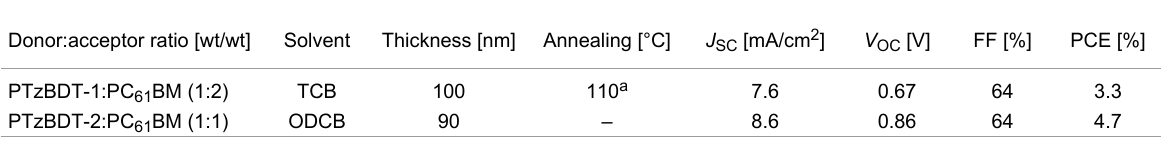
Donor:acceptor ratio [wt/wt]